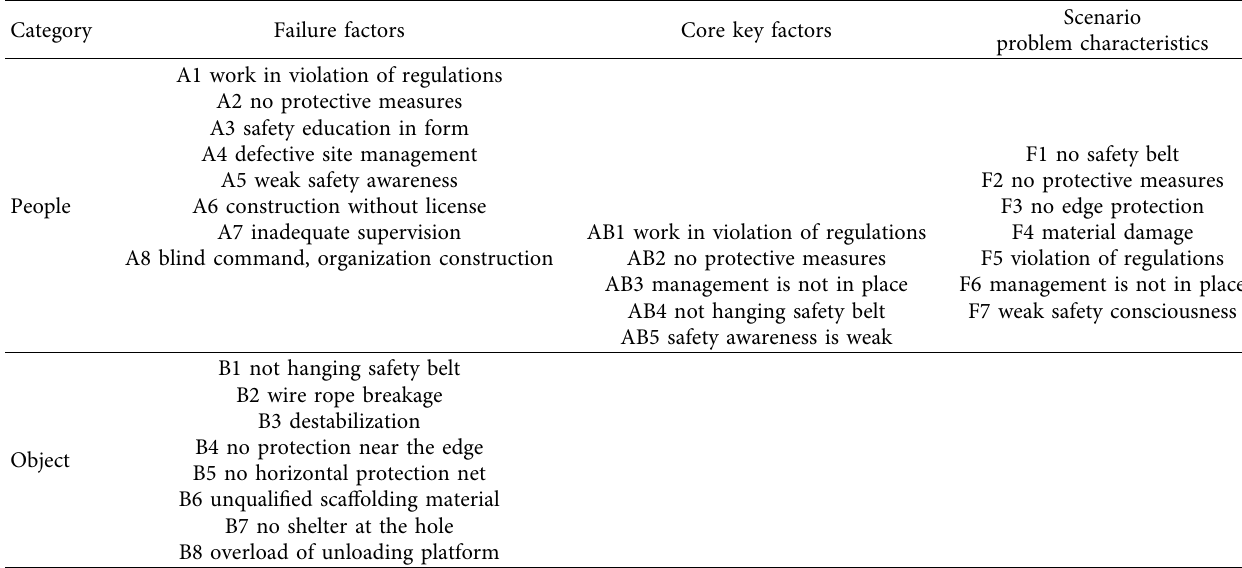
Table 1: Features of unsafe scene of